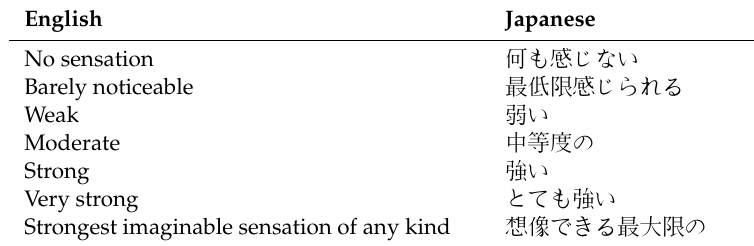
Table A1. Rating of sweet, sour and salty taste intensities of sweet-tasting foods (mu ffi n, sweet yogurt and banana).